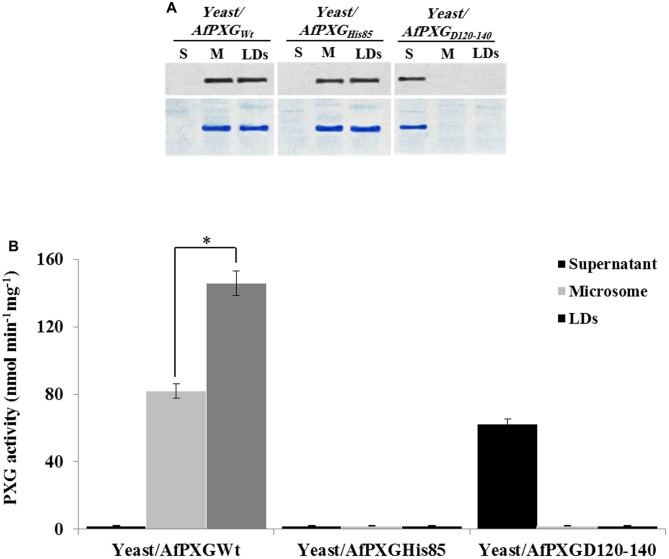
Expression, subcellular localization and enzymatic activity of AfPXG variants. (A) Immunodetection of the mutated proteins AfPXGHis85 and AfPXGD126-140 or native AfPXGWT in different subcellular fractions, supernatant (S), microsomes (M), and lipid droplets (LDs) isolated from the recombinant yeast. An antibody anti-PXG was used at dilution of 1:500. A horseradish peroxidase-conjugated anti mouse IgG diluted 1:2000, served as the secondary antibody. Loading control are gels stained with Coomassie Brilliant Blue. (B) Evaluation of the PXG activity (hydroxylation of aniline) in the respective subcellular fraction isolated from the recombinant yeast/AfPXGHis85, yeast/AfPXGD126-140 and yeast/AfPXGWT. All measurements were done in triplicate. Values are the means ± SD (n = 3). The differences in PXG activity between microsomes and LDs were significant (∗P < 0.05).